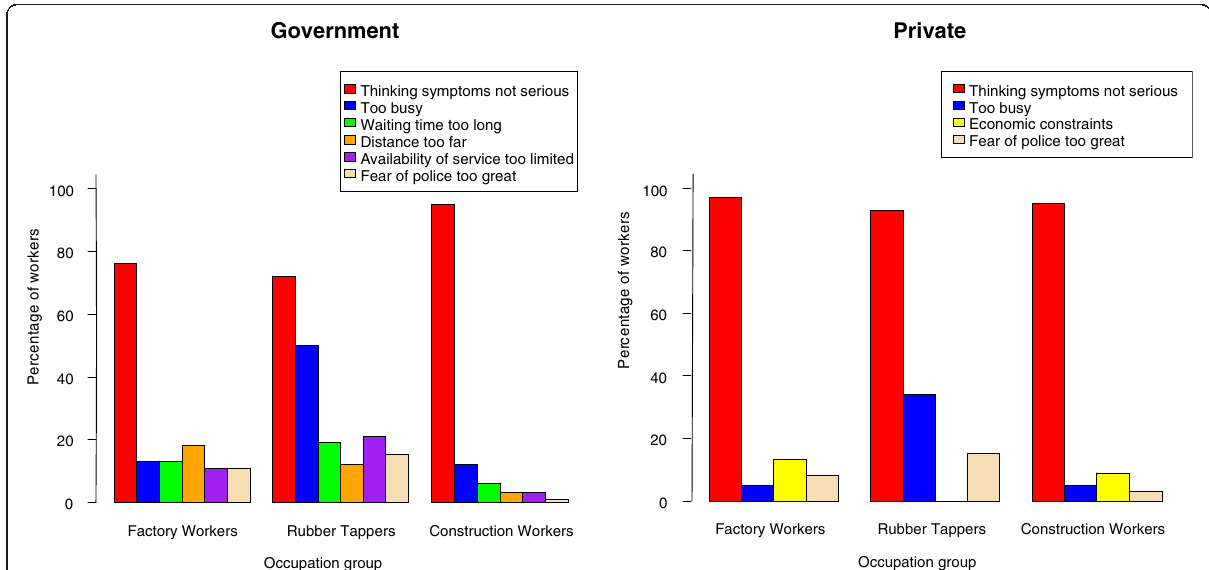
Figure 1 Reasons for not using government or private healthcare facilities for TB-suspicious